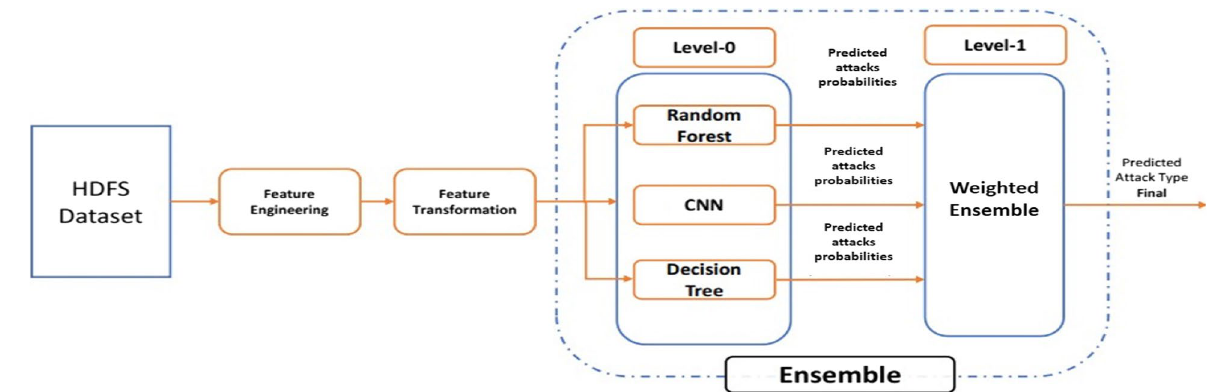
Fig. 6 Deep ensemble configuration for multi-class prediction